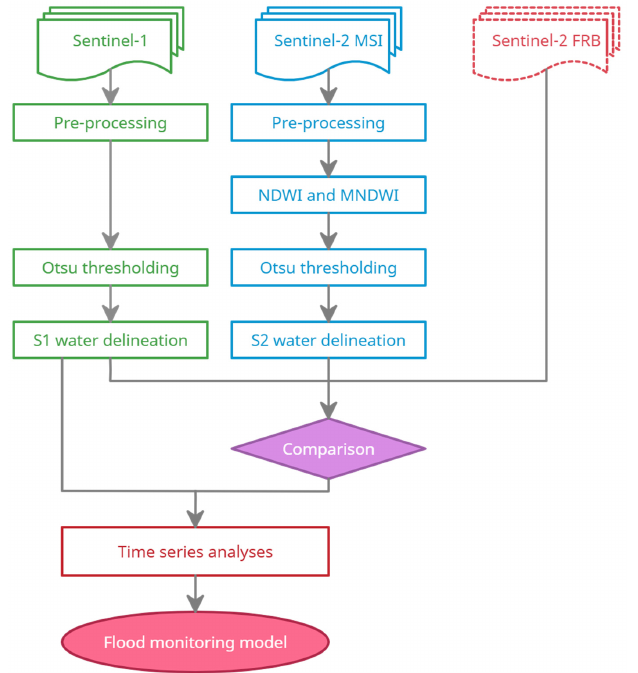
Figure 3. Flowchart for surface water mapping and flood monitoring using Sentinel-1 SAR image time series and Otsu threshold.